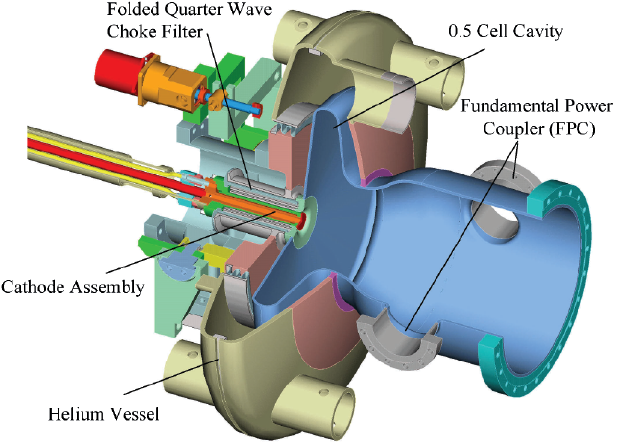
FIG. 7. Spectral response of CsK 2 Sb BNL cathodes, measured at room temperature. Courtesy of John Smedley,